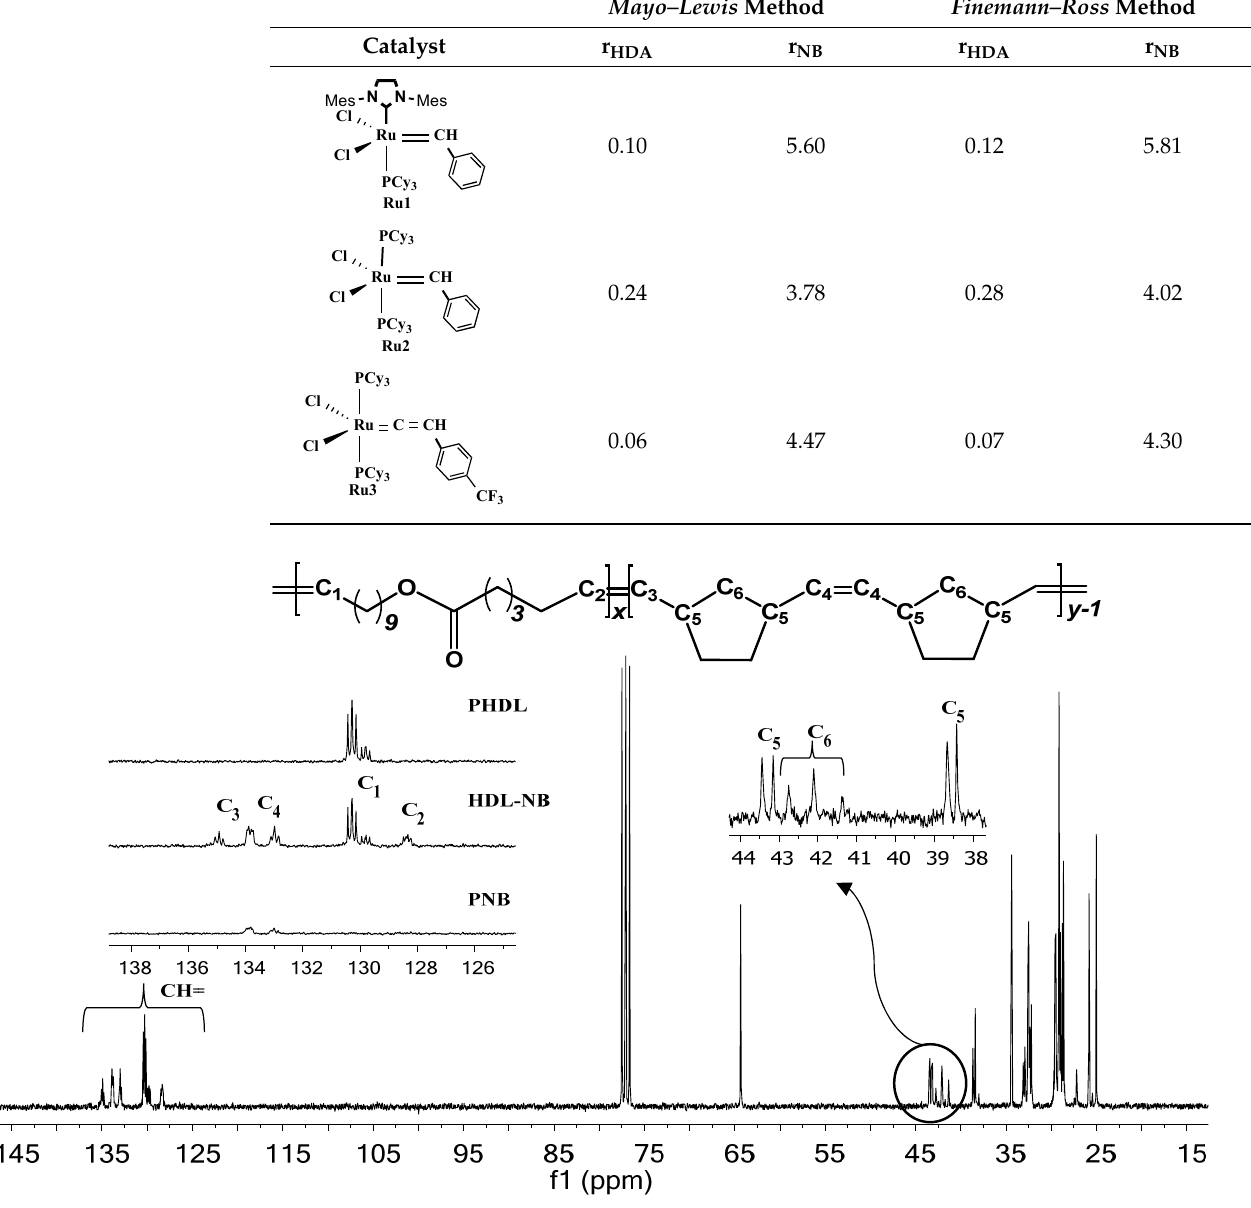
Figure 2. 13 C-NMR (100 MHz, CDCl 3 ) spectrum for the copolymer HDL-NB (Table 1, entry 7 ). Differential scanning calorimetry (DSC) provides a tool for monitoring the HDL-NB copolymers’ crystallinity. All thermal transition temperatures of the HDL-NB copolymers were determined using second heating scans from − 80 °C to 300 °C at 10 °C/min. Figure 3A shows the DSC thermograms of pure PHDL and all HDL-NB copolymers except amorphous PNB. Table 4 contains the melting point T m and enthalpy of fusion Δ H m parameters of the studied copolymers extracted from the DSC data; the glass transition temperature (T g ) was not detected in the scanned heating range. An endothermic peak was observed around 47.60 °C, as was an enthalpy of fusion Δ H m = 73 J/g, which corresponds to the melting point of PHDL. It is possible to observe that the T m and Δ H m decreased as the norbornene amount is increased, indicating that the PNB units permeate through the HDL chains.